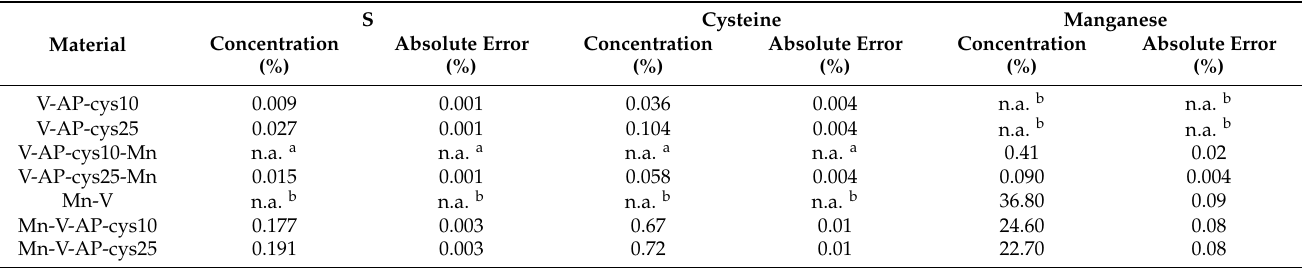
Table 2. Percentage of Cysteine and Manganese in the V and Mn-V